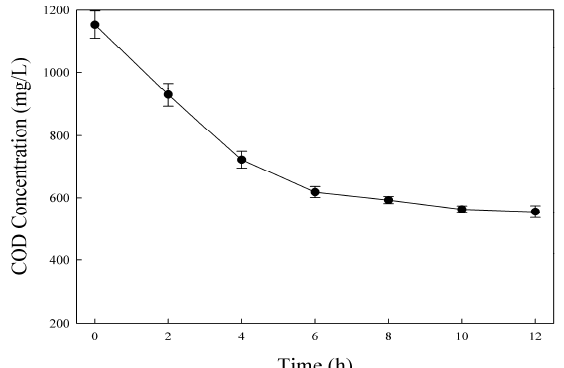
Figure 3. Change of COD during the decolorization of dyes by the anaerobic sludge.